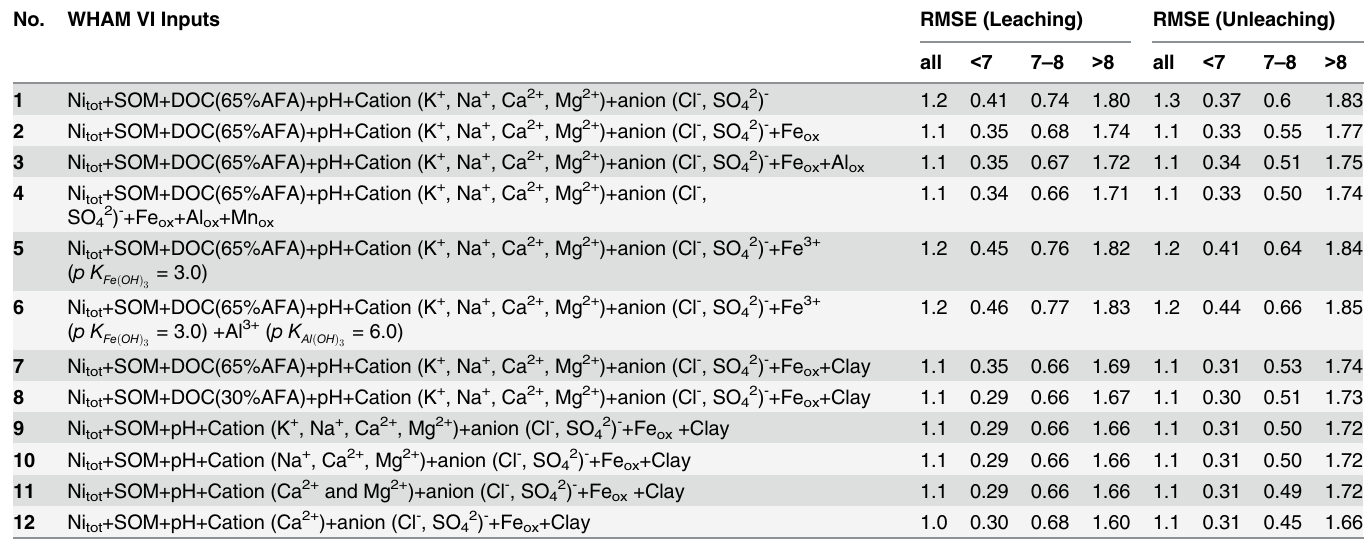
Table 3. Effects of the input variables on the RMSE between the predicted soluble Ni concentrations by WHAM and measured values. (The temper- ature is set at 293K and the partial pressure of CO 2 (pCO 2 ) is set at 10 − 3.5 atm). No. WHAM VI